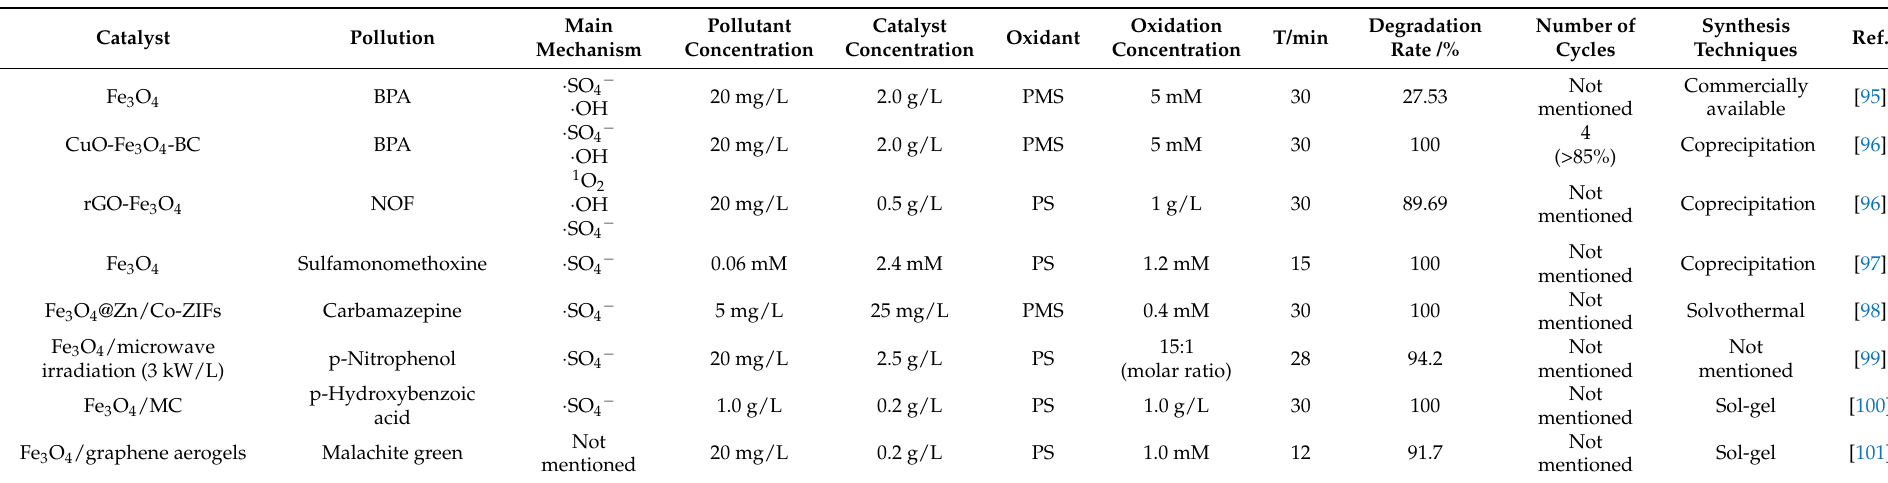
Table 4. Effects of Fe 3 O 4 and its composite-material-activated PS/PMS on degradation of different kinds of wastewater